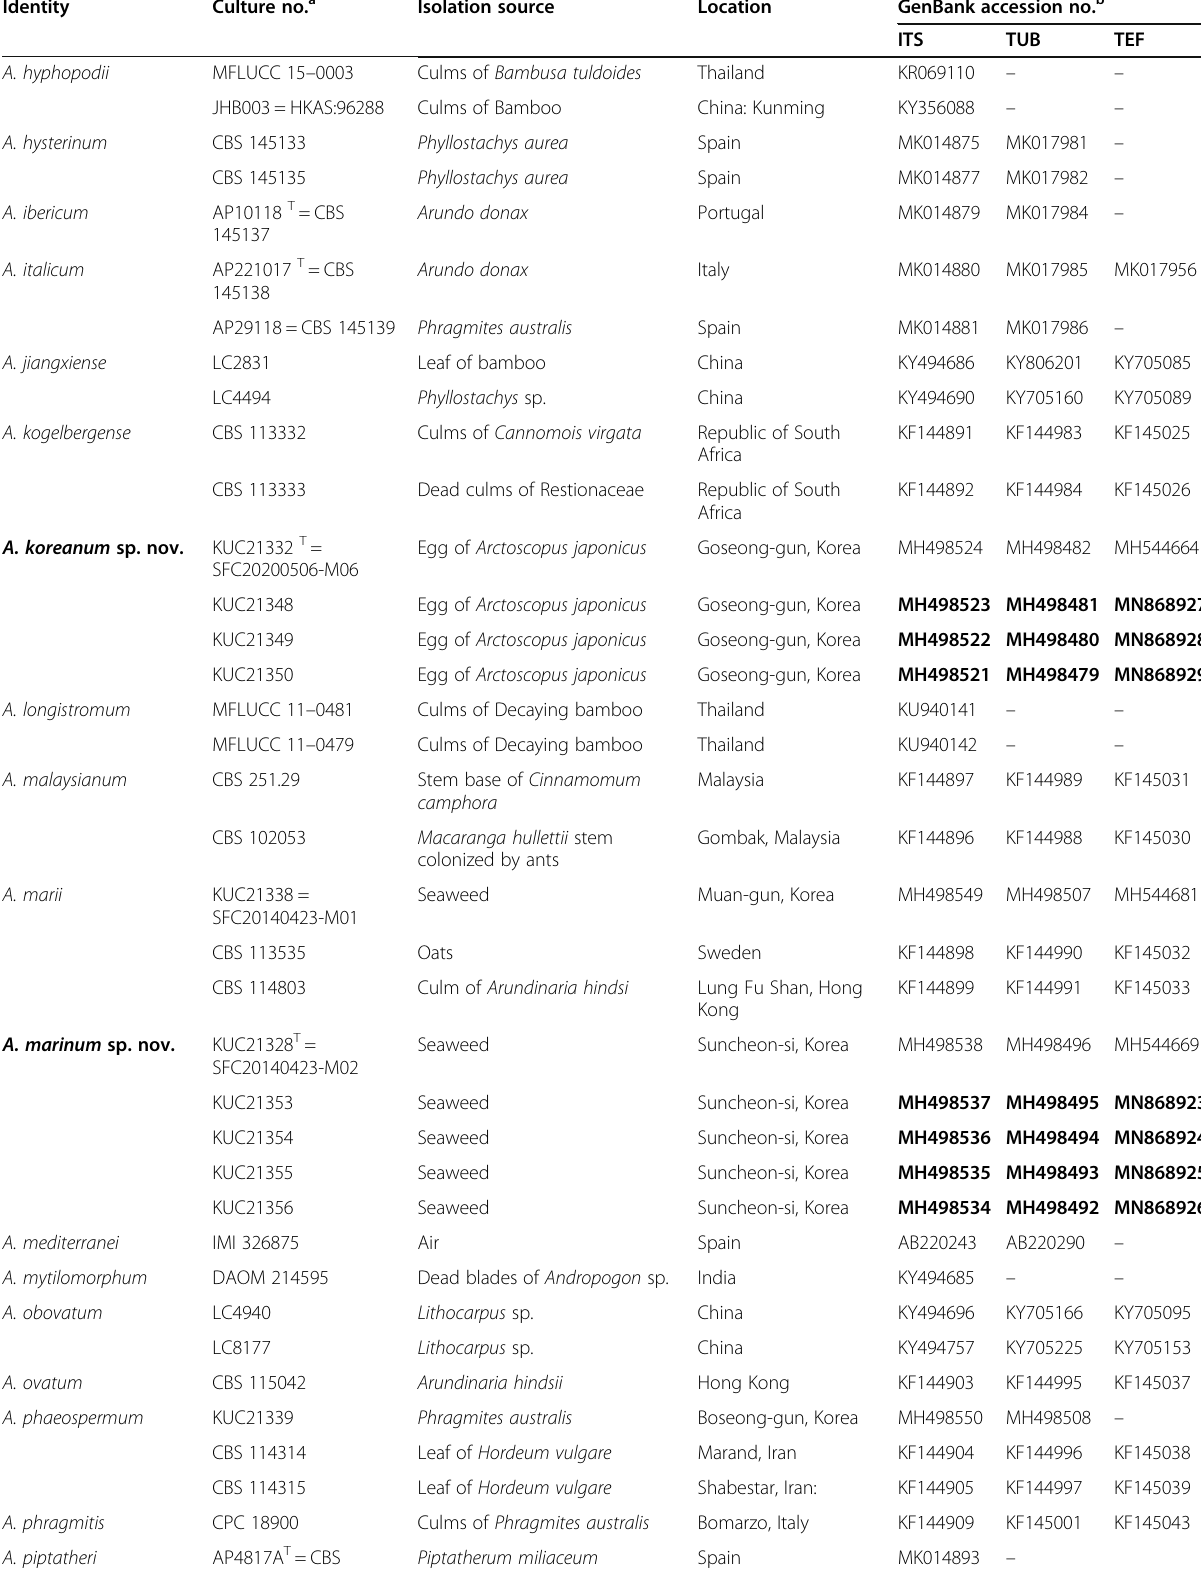
Table 1 A list of all the strains included in the phylogenetic analysis (Continued)